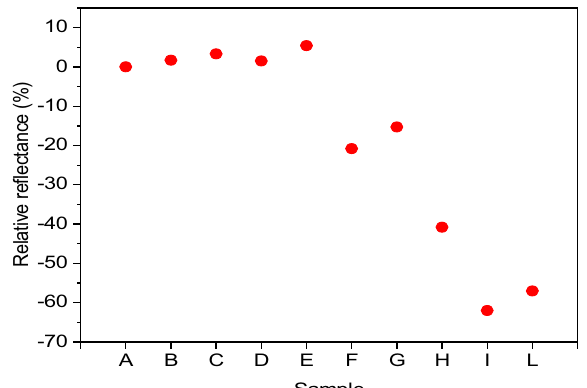
Figure 4. Relative reflectance of each sample to A estimated by UV–Vis spectrophotometry.